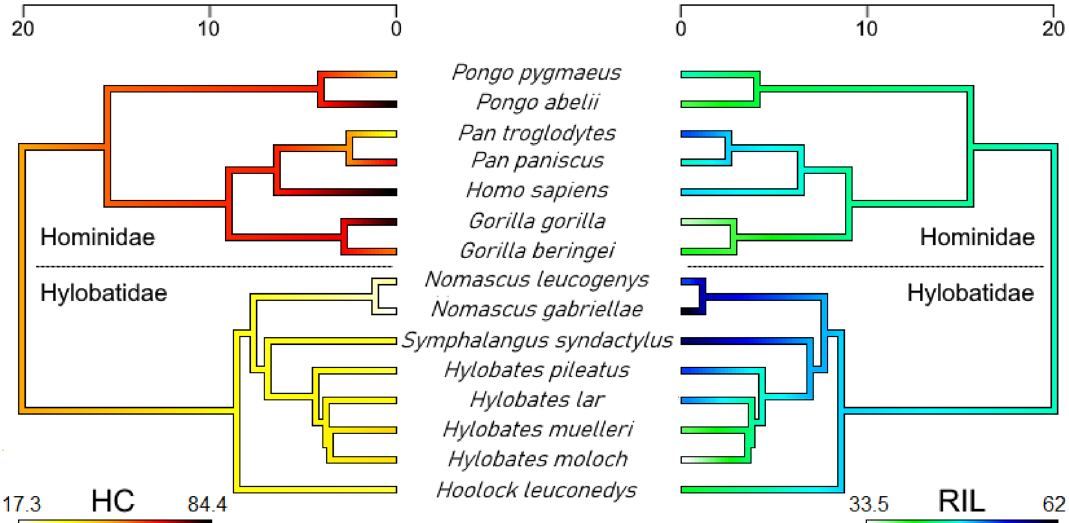
Figure 5. Visualization of phylogenetic patterns in species means of highest ocular contrast (HC, left) and relative iris luminance (RIL, right) in the ape superfamily (Hominoidea). Note the discrepancy between the two measures and the secondary acquisition of a gibbon-like HC in chimpanzees ( Pan troglodytes ). Time scales correspond to million years before present. Maximum likelihood ancestral state estimates at the nodes of the trees are provided in Supplementary Table 3. Species Hoolock leuconedys Hylobates lar Hylobates moloch Hylobates muelleri Hylobates pileatus Symphalangus syndactylus Nomascus gabriellae Nomascus leucogenys Gorilla